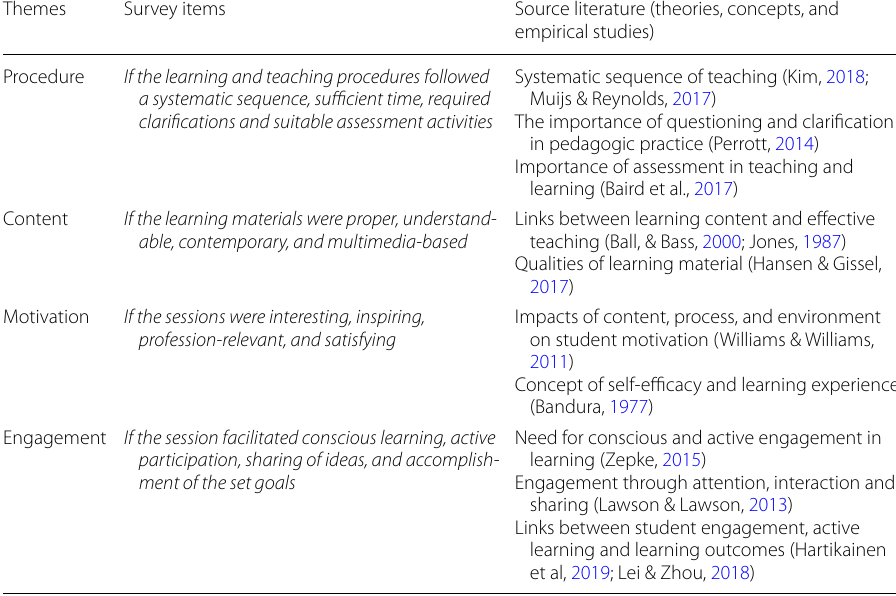
Table 1 Themes and items of the survey questionnaire